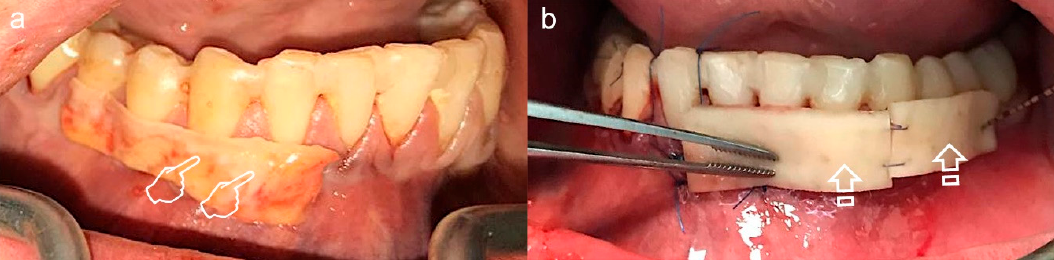
Figure 4. Split-mouth recessions treatment, connective tissue graft (CTG) for quadrant IV ( a ) and acellular dermal matrix (ADM) for quadrant III ( b ). Try-on of the harvested CTG (pointers) and ADM (arrows) for decision-making: large enough for a tunnel procedure.